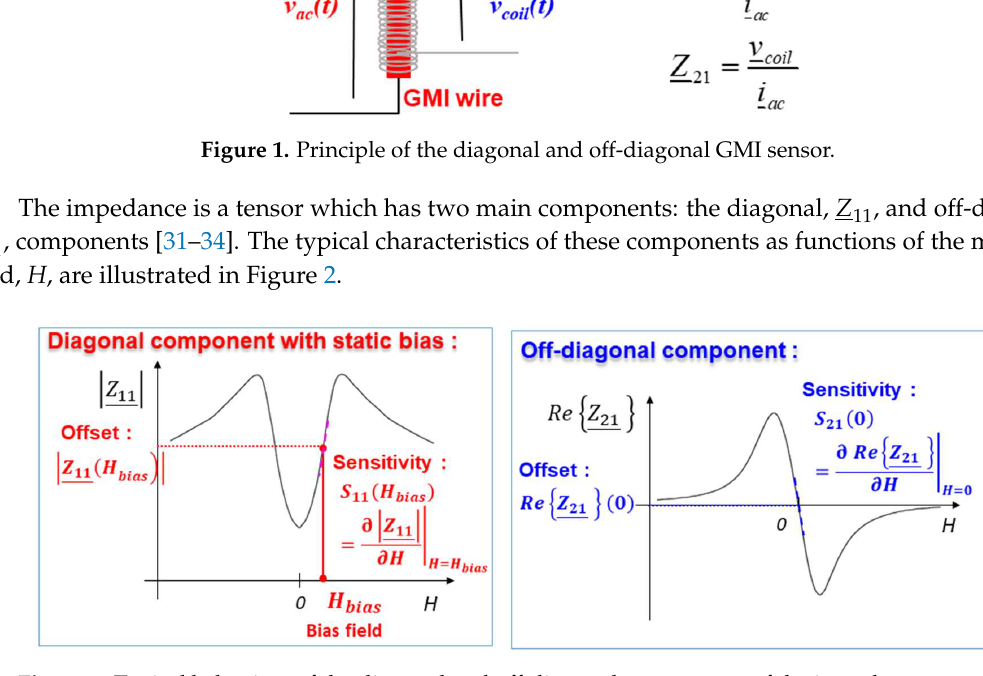
Figure 2. Typical behaviors of the diagonal and off-diagonal components of the impedance tensor in amorphous wires.